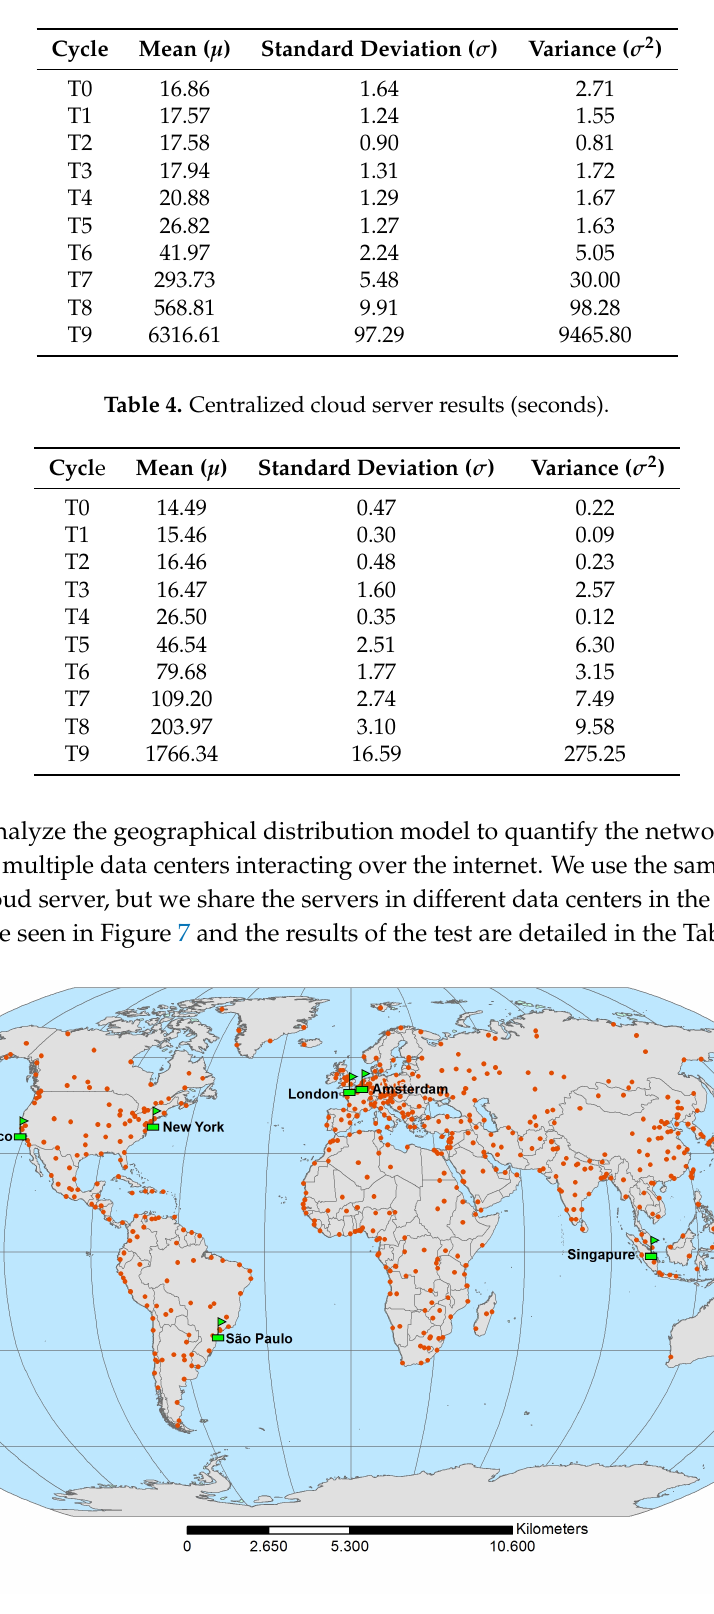
Table 3. Distributed cloud server results (seconds).